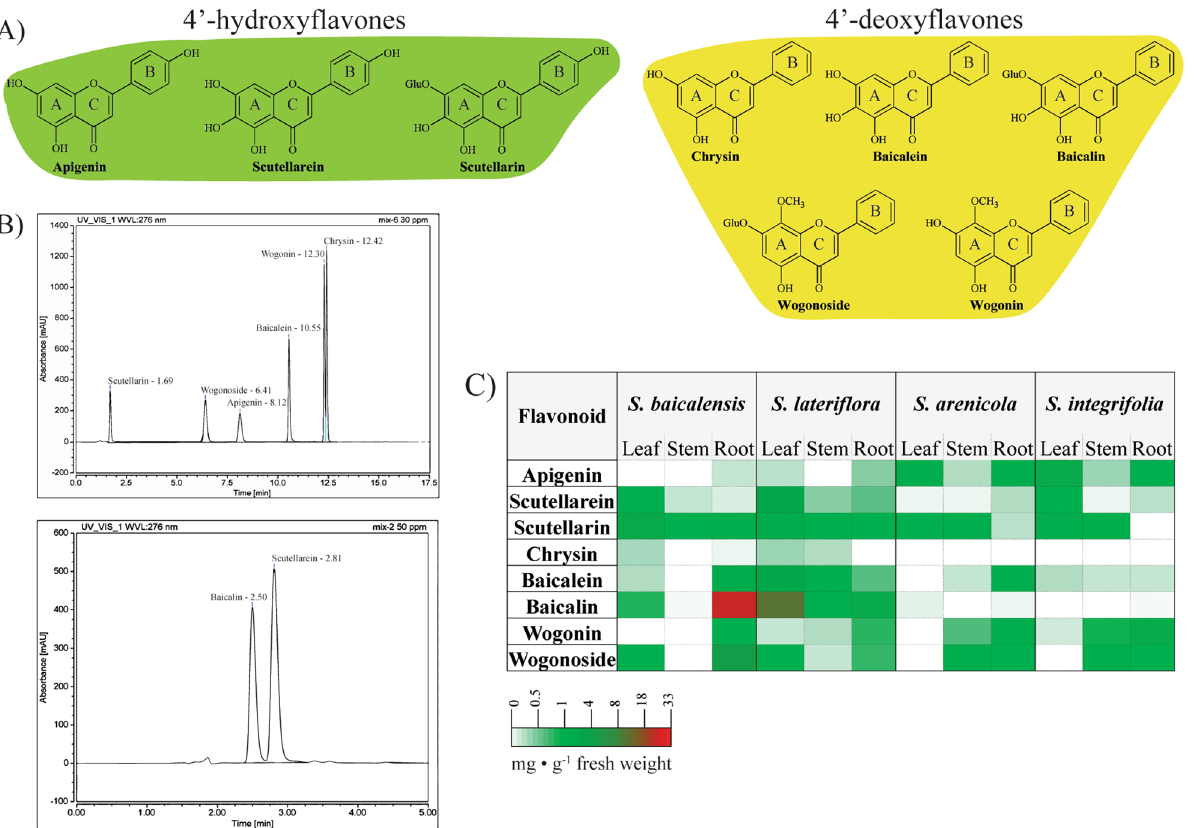
Figure 4. Identification and quantification of selected flavones from four Scutellaria species used in this study. ( A ) Structures of the 4 ′ —hydroxyflavones and 4 ′ -deoxyflavones analyzed in the study. ( B ) External standard chromatograms obtained by HPLC analysis. ( C ) Heat map, indicating relative concentrations of all eight flavones determined by HPLC along with their localization patterns in aerial and underground tissues of the Scutellaria species . HPLC = High performance liquid